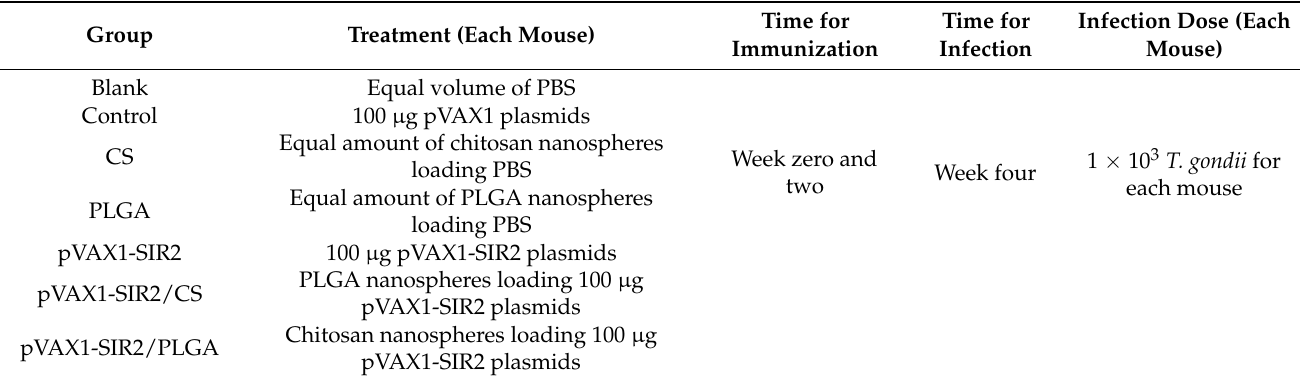
Table 1. Immunization and challenge procedures in